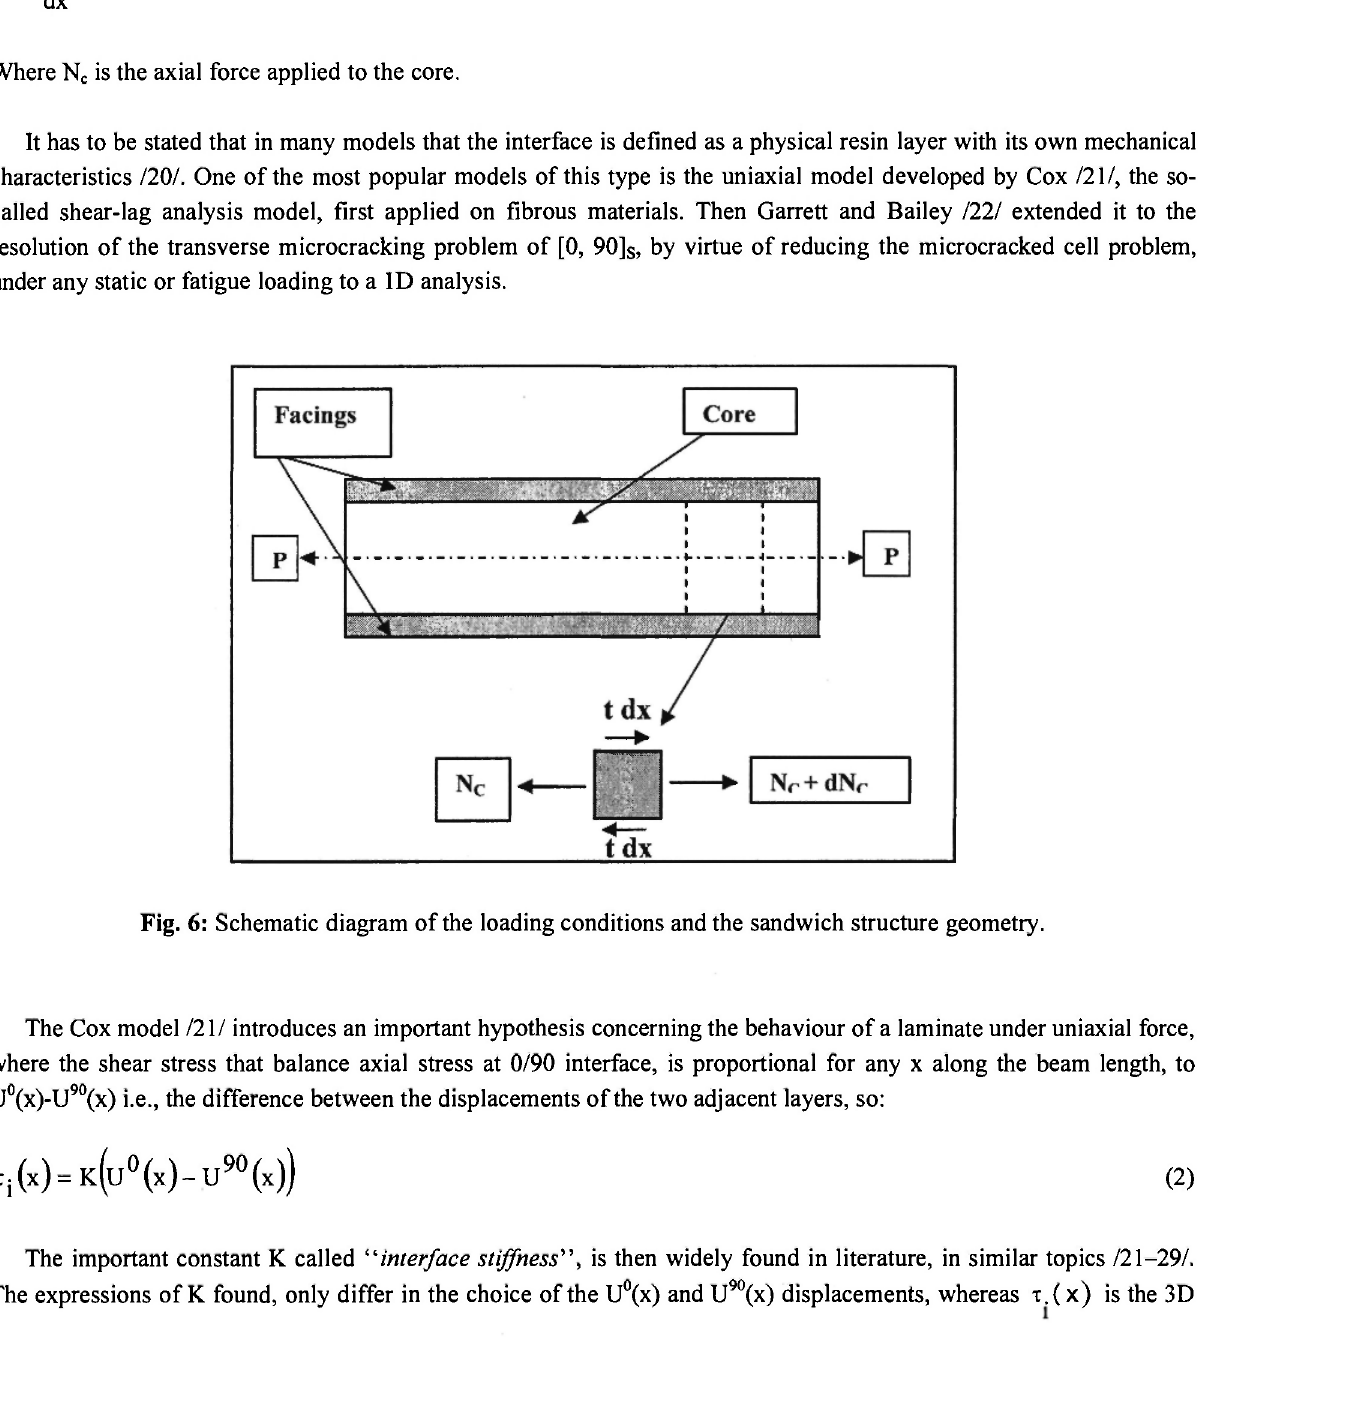
Fig. 6: Schematic diagram of the loading conditions and the sandwich structure